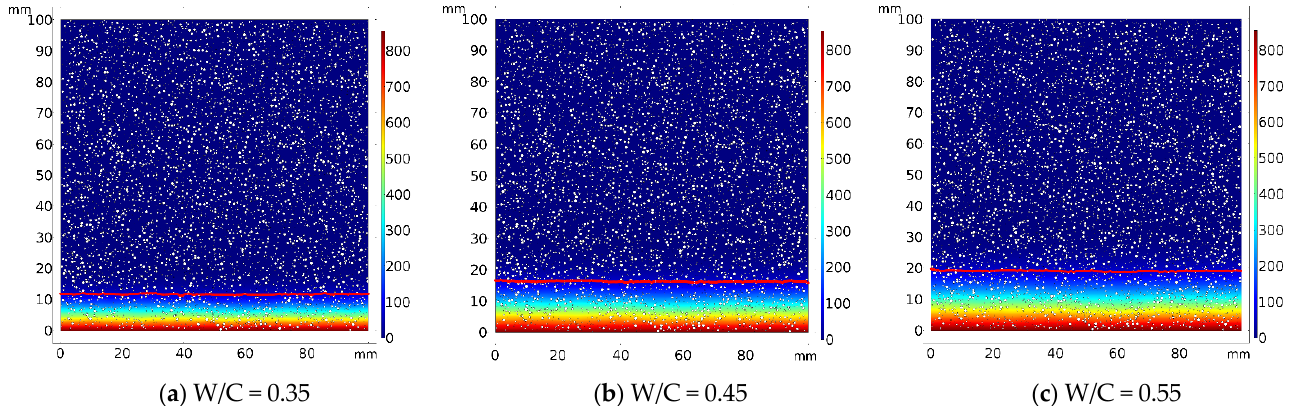
Figure 3. Test results of chloride ion diffusion under different w/c ratios while under hydrostatic pressure of 0.5 MPa. Table 8. Test and simulation results for the cement mortar.